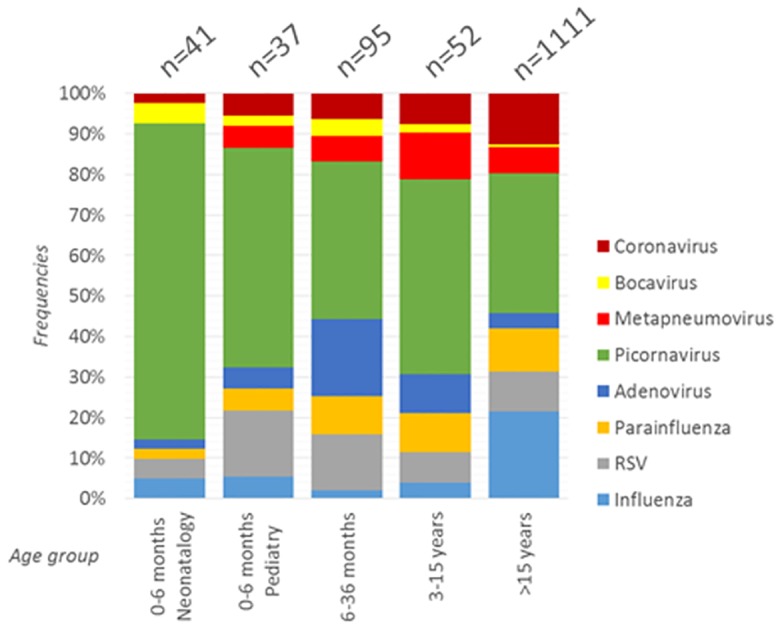
Distribution of all respiratory viruses isolated across age strata.The total number of isolated viruses is indicated at the top of each bar.